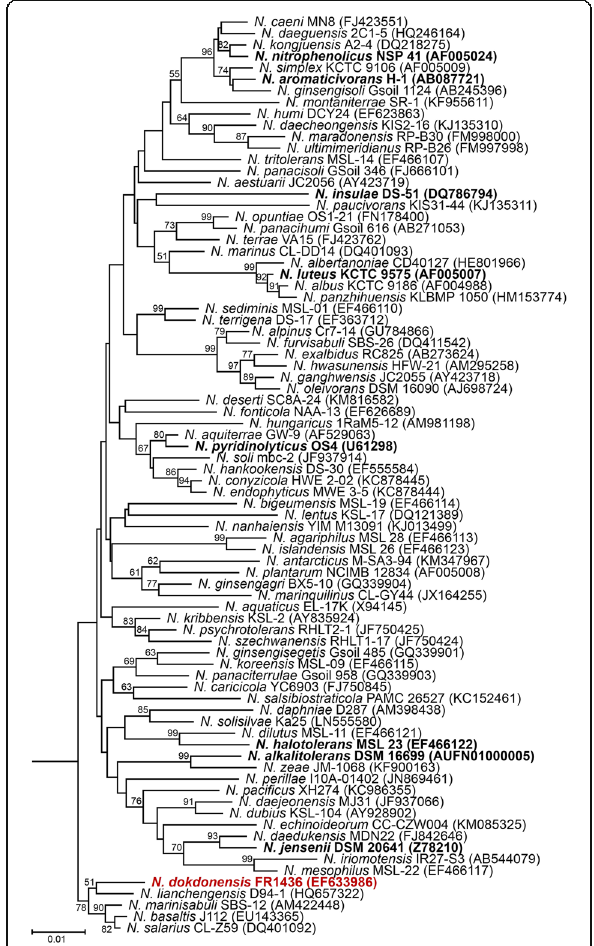
Fig. 2 Phylogenetic relationship of the species in Nocardioides . A neighbor-joining tree based on the 16S rRNA gene was generated using MEGA 5 and Jukes-Cantor model was used for calculation of evolutionary distance based on the comparison of 1275 nucleotides. Bootstrap values (percentages of 1000 replications) greater than 50% are shown at each node; Nocardia asteroids NBRC 15531 (BAFO01000006) was used as an out-group. Scale bar represents 0.01 nucleotide substitutions per site. Accession numbers of the 16S rRNA gene are presented in the parentheses. Species for which genome sequences are available are